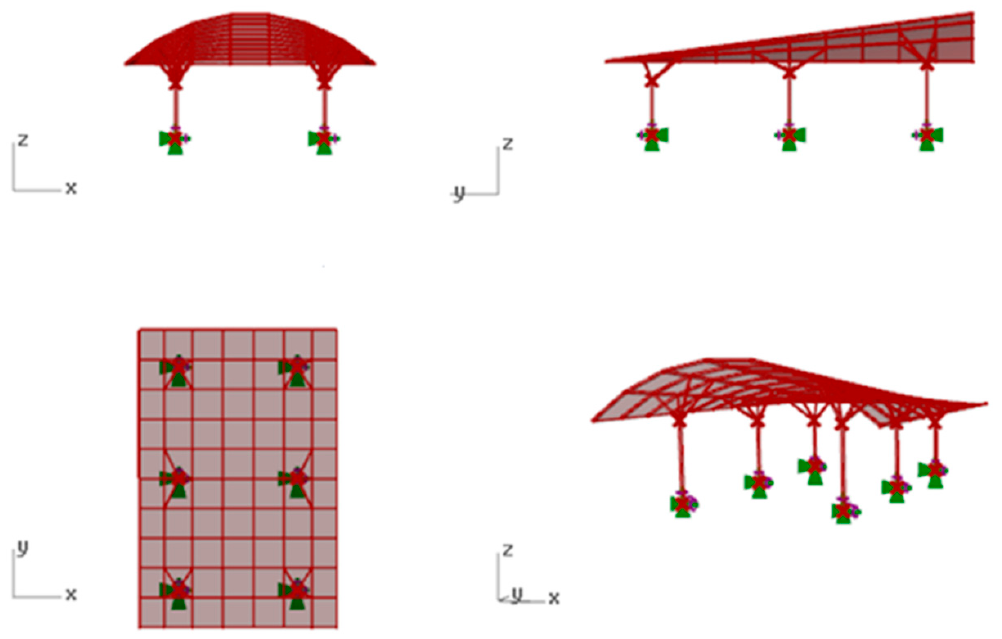
Figure 8. Views of the conoid canopy roof—determination of the roof inclination angle.